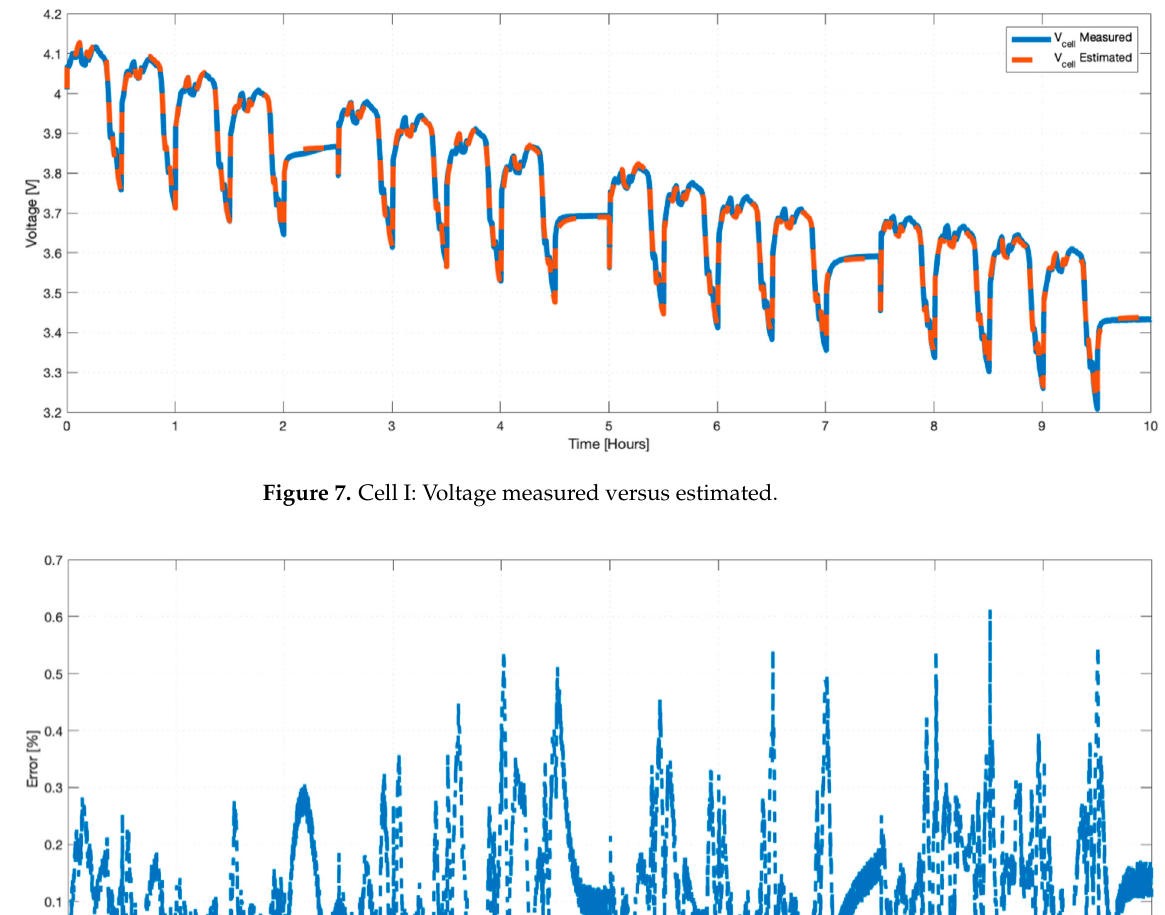
Table 5. Selected solver option set.